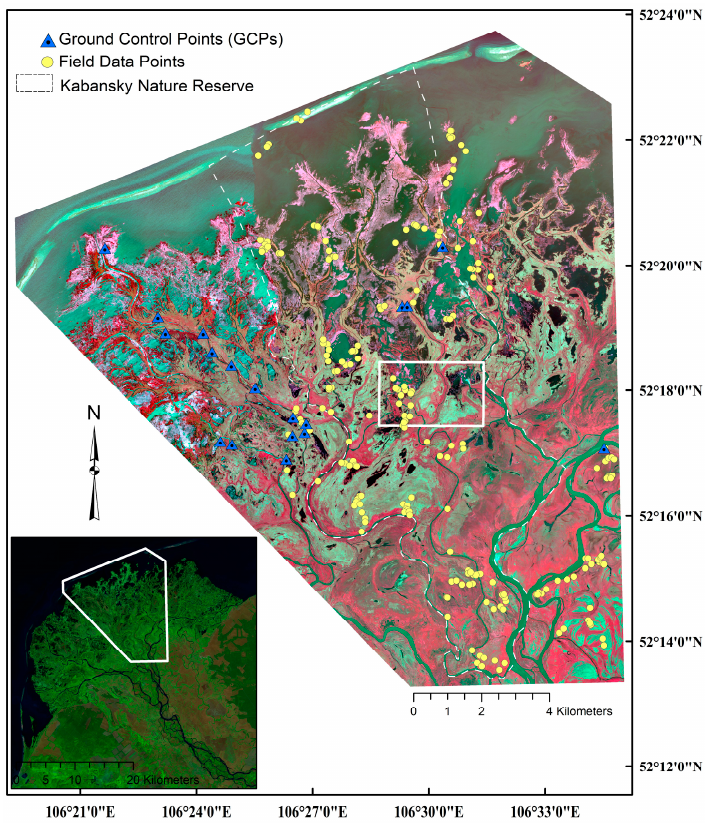
Figure 2. False color composite (NIR-1, Red and Green bands) of the focal study area within the Selenga River Delta and the location of the both the field collection points and ground truthing sites. The white-colored box indicates the location of an area of interest analyzed to generate wetland class and aquatic habitats classification thematic maps using the four classifiers.